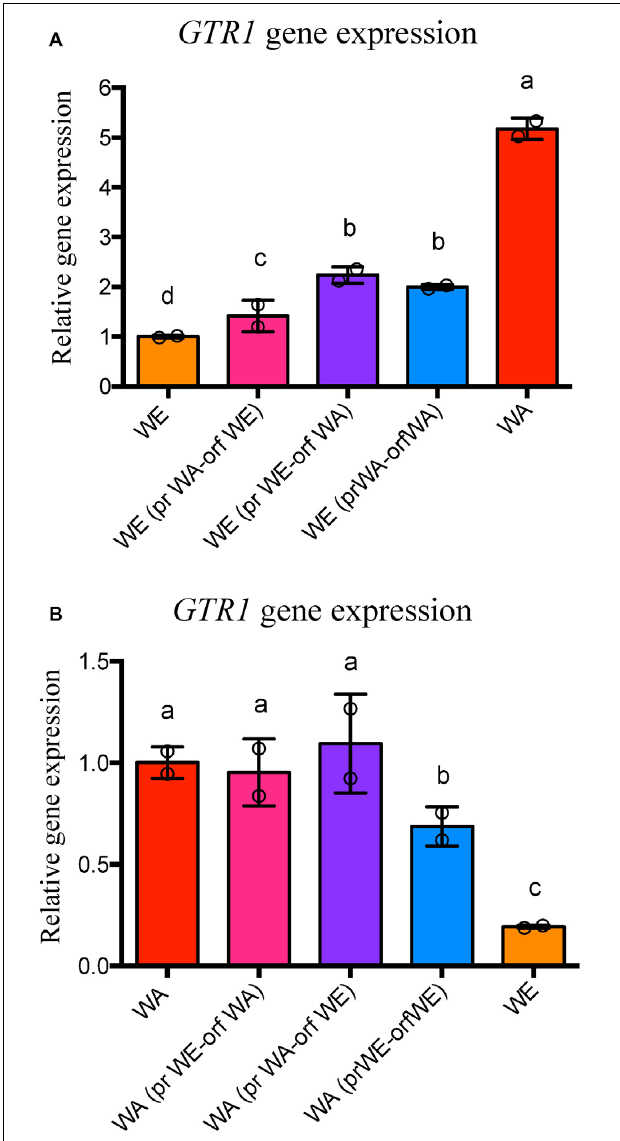
FIGURE 4 | GTR1 gene expression in strains with swapped regions. (A) Relative gene expression at 6 h of fermentation for the GTR1 gene in the WE strains with swapped regions of GTR1 coming from the WA strains. Expression levels are relative to the WE strain. (B) Relative gene expression at 6 h of fermentation for the GTR1 gene in the WA strains with swapped regions of GTR1 coming from the WE strains. Expression levels are relative to the WA strain. In both panels, expression levels were normalized using three housekeeping genes. Plotted values correspond to the average of two biological replicates (dots), with their standard error represented by bars (mean ± SE). Different letters represent significant statistical differences between the strains constructed and wild type strains (Mood test with p < 0.05). WE: Wine/European; WA, West African; pr, Promoter; orf, Open Reading Frame